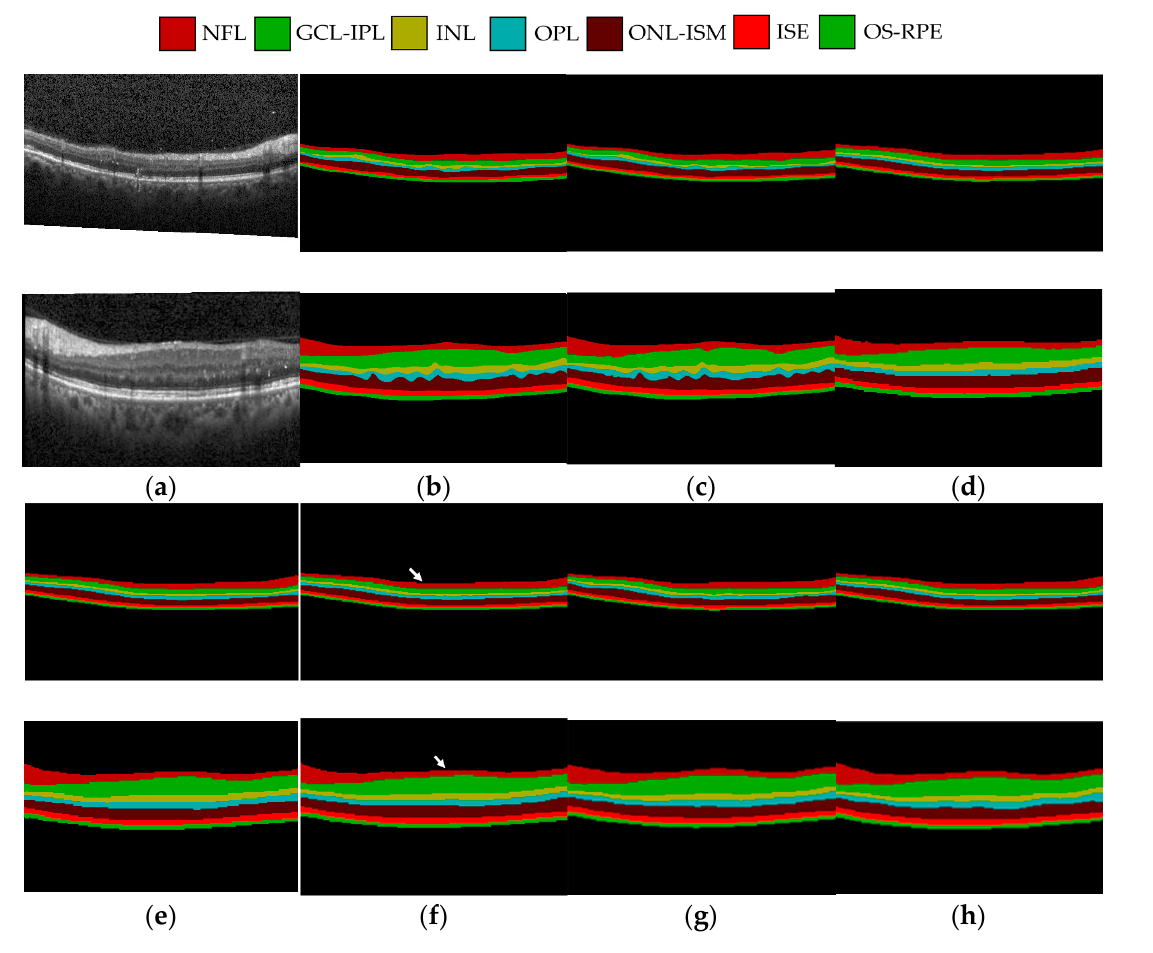
Figure 8. Qualitative comparison of OCT image segmentation: ( a ) The original OCT image;